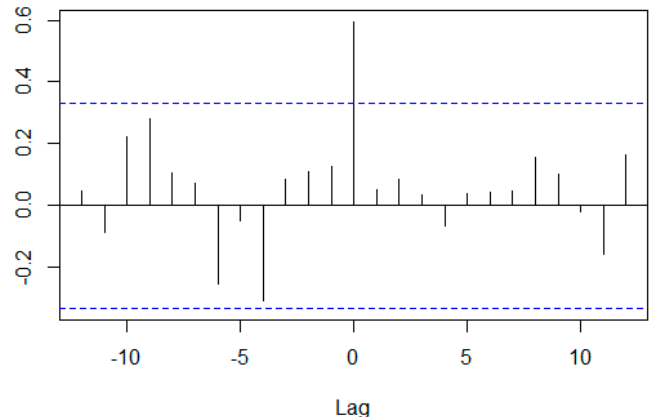
Figure 15. Cross-correlation coefficient between the average BHAR of the whole sample group and the average BHAR of the camera group for Jan 2010–Dec 2012.